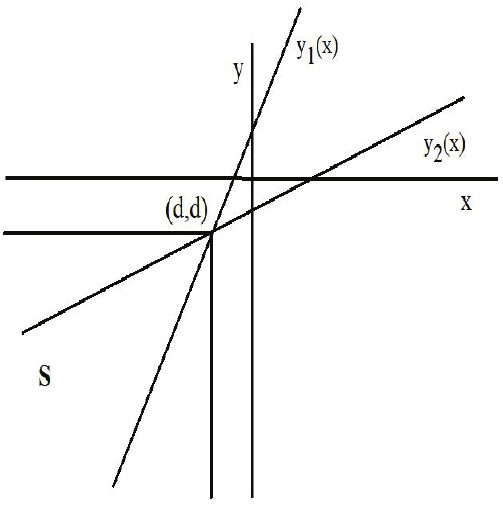
Figure 3. Region of systemic crisis for general